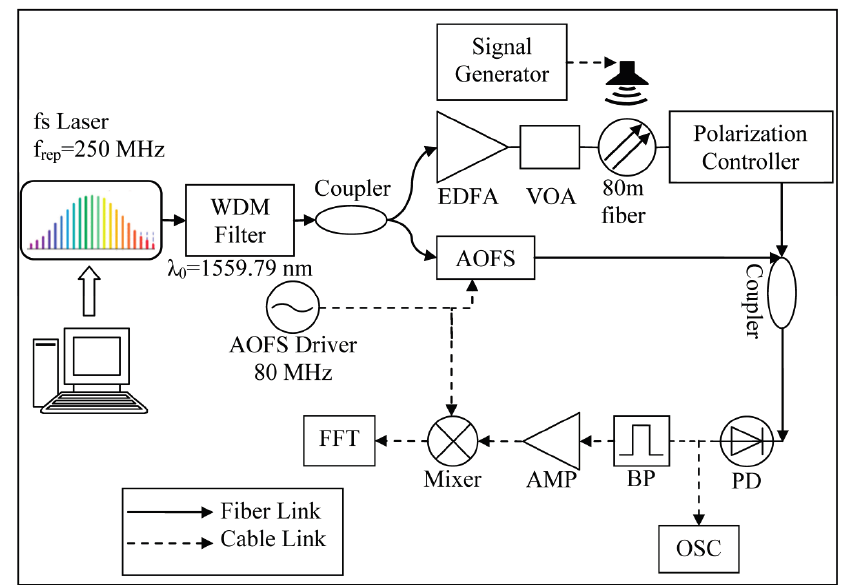
Figure 1. Schematic of the experimental setup for characterizing the excess phase noise spectra of optical frequency transfer in a fiber link under external acoustic perturbations. AMP, microwave amplifier; BP, band pass filter; OSC, oscilloscope; WDM, wavelength division